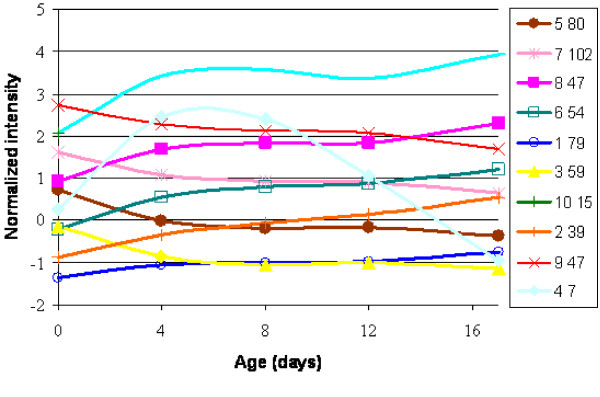
Expected cDNA expression trajectories for each of the 10 clusters identified in the ligustica (L) data set using a clustering approach. The legend indicates the group number and the estimated number of cDNAs per group.